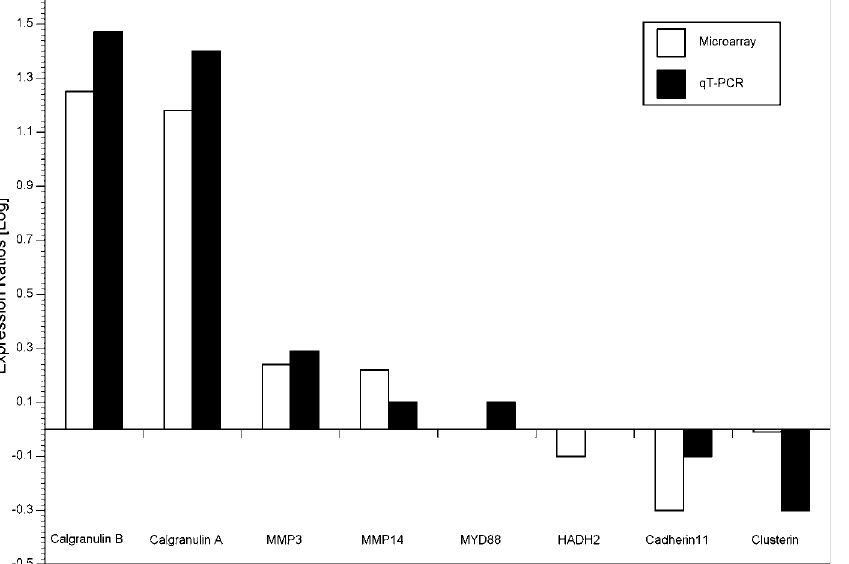
Figure 6. qRT-PCR Confirmation of the Results of Microarray Hybridization The graph represents fold-changes of expression in lymphedema, relative to normal controls, for each of eight representative genes, by microarray hybridization and qRT-PCR. For MYD88 by microarray and HADH2 by qRT-PCR, the log (gene expression) equaled zero. HADH2, hydroxysteroid (17-beta) dehydrogenase; 2MMP, matrix metalloproteinase; MYD88, myeloid differentiation primary response gene 88. DOI: 10.1371/journal.pmed.0030254.g006